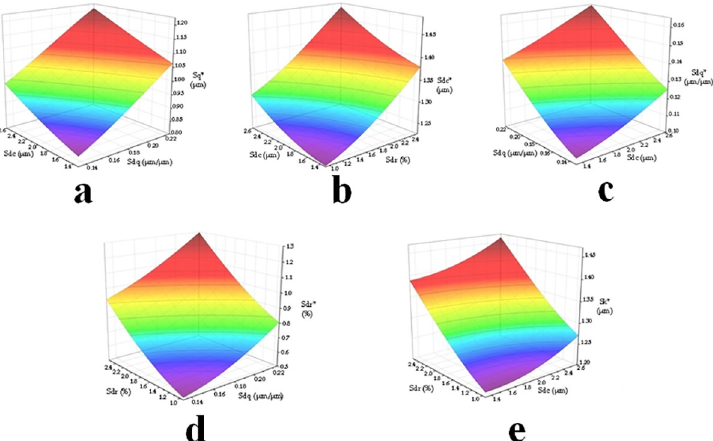
Fig 11. Influence of parameters in running-in. (a) The impact trend between Sq � and Sdc and Sdq. (b) The impact trend between Sdc � and Sdc and Sdr. (c) The impact trend between Sdq � and Sdc and Sdq. (d) The impact trend between Sdr � and Sdr and Sdq. (e) The impact trend between Sk � and Sdc and Sdr.